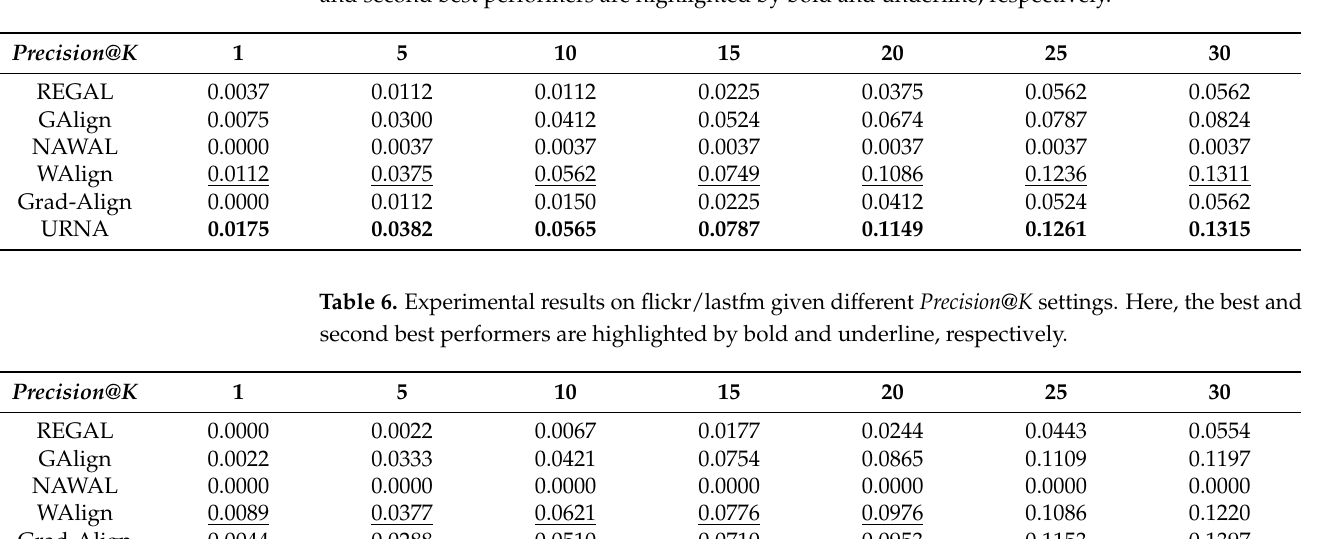
Table 5. Experimental results on flickr/myspace given different Precision @ K settings. Here, the best and second best performers are highlighted by bold and underline, respectively.